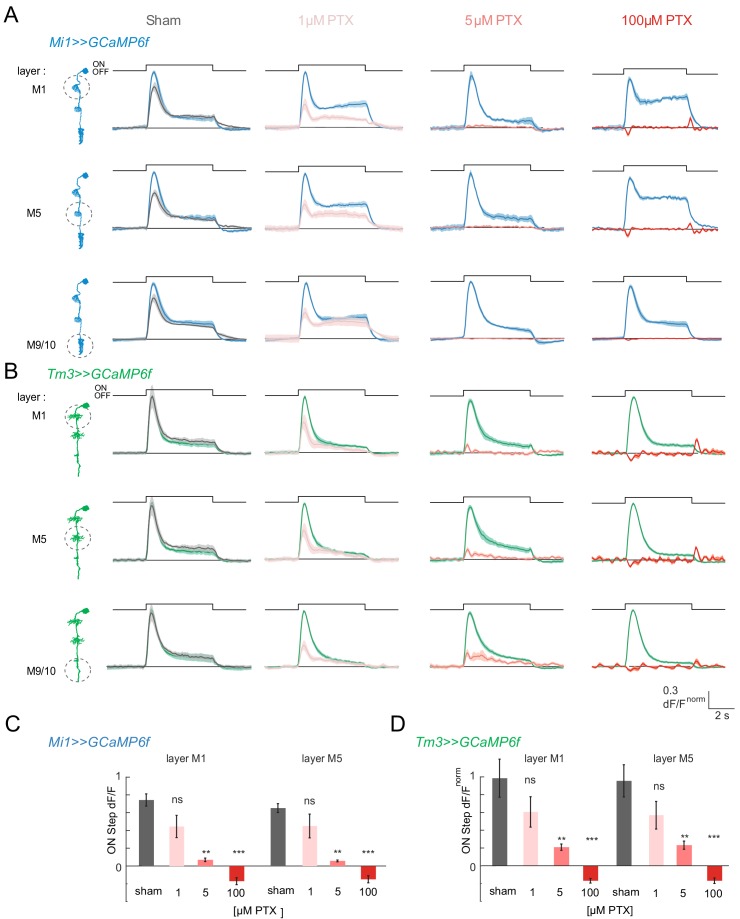
ON responses are abolished by PTX concentrations affecting GABAARs and GluCls.(A,B) In vivo GCaMP6f signals recorded in layers M1, M5 and M9/10 of Mi1 (A) and Tm3 (B) neurons, before (blue, green) and after (gray, red) application of 0 (sham), 1, 5 or 100 µM PTX. (C,D) Bar plot showing the quantification of the ON step in (A,B). Sample sizes: sham, n = 5 (89); 1 µM, n = 5 (68); 5 µM, n = 5 (64); 100 µM, n = 5 (89). All traces show mean ± SEM. All sample sizes are given as number of flies (number of cells). *: p<0.05, **: p<0.01, ***: p<0.001, tested with a one-way ANOVA and a post-hoc unpaired t-test with Bonferroni-Holm correction for multiple comparisons.10.7554/eLife.49373.008Figure 2—figure supplement 2—source data 1.Table 1 contains all mean ± s.e.m.Data related to quantifications shown in main Figure 2—figure supplement 2, sorted by genotype and experimental condition.